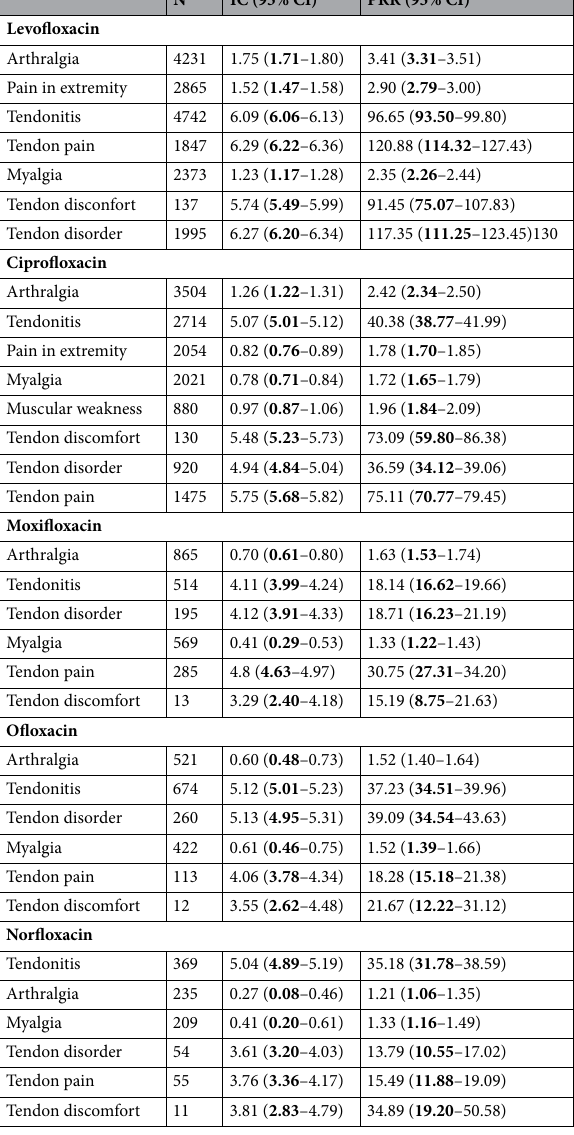
Table 4. Disproportionality data analysis. Bolded text represents IC025 and PRR025, the lower ends of the 95% respective confidence intervals. CI confidence interval; IC information component; N number of reports; PRR proportional reporting